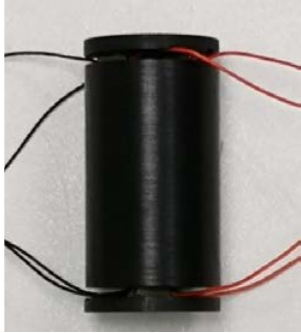
Figure 5. A picture of the HAPA-(2 + 2) actuator with square-cross-sectioned recesses made from four NEC-Tokin piezoceramic stacks of 5 × 5 mm 2 in cross-section and 40 mm in length.